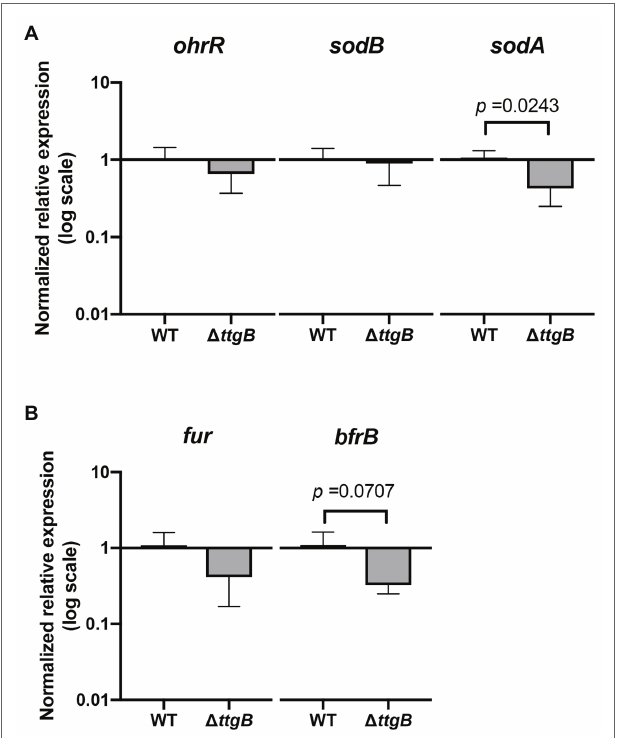
FIGURE 5 | Bipyridyl toxicity is not related to oxidative stress due to iron accumulation. (A) Relative expression levels of genes involved in oxidative stress and (B) iron metabolism were analyzed by qRT-PCR of mRNA isolated from the wild type and ttgB strain in KB plus 0.5 mM Bip. The target genes were normalized against the reference gene ( rpoD ) using the wild type strain as the control group. The data represent three independent